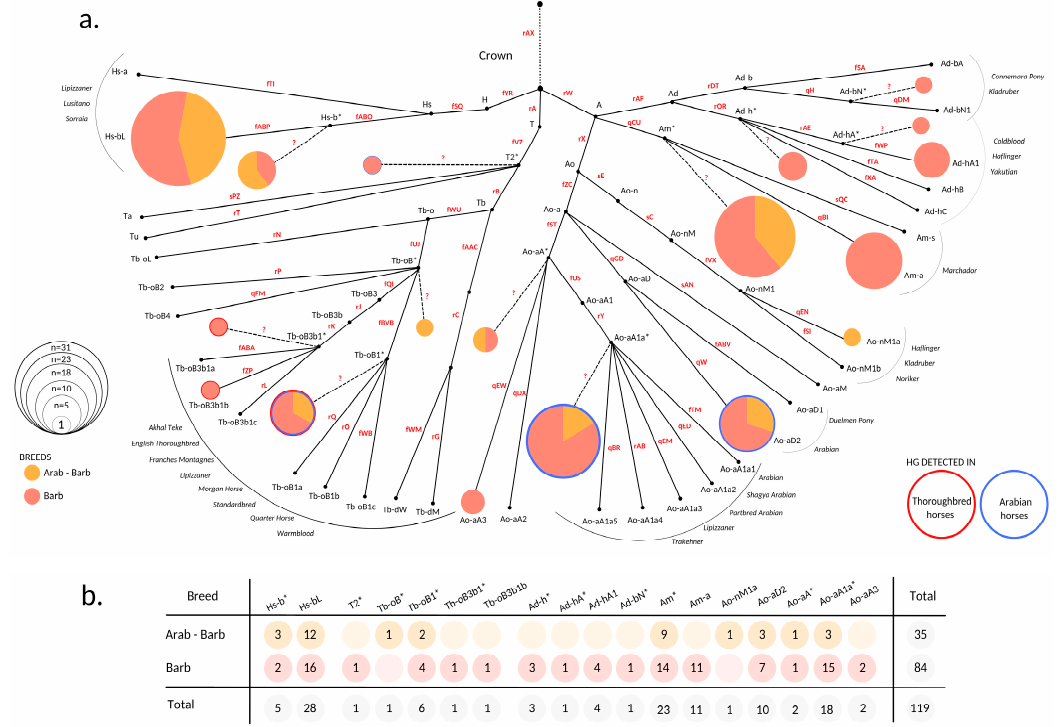
Figure 1. MSY haplotype spectra of North African horses. ( a ) HT frequency plot based on the MSY tree after [38,39]. HT determining variants used to construct the downscaled tree for genotyping are denoted on branches in red. Additional information is given in Supplement, Table S2. Clustering of 119 North African horses based on genotyping result is illustrated as pies. Pie radiuses are scaled to the number of allocated individuals and colors of the portions correspond to different breeds. HG names are labeled accordingly. HTs located on internal nodes are denoted with an asterisk (*) and trailed with dashed lines that originate from corresponding internal nodes. Unascertained variants that would determine * HTs are denoted with question marks (?). HTs framed with blue and/or red borders denote that they were detected previously in Arabian (blue border) and Thoroughbred (red border) horses [38,39]. Non-colored points express HTs that were not detected in the North African sample set. Gray list on the sides of the network indicates the breeds the HTs were previously reported [38–40]; ( b ) Number of individuals that allocate within detected HTs. Sample information details are given in Supplement Table S1.